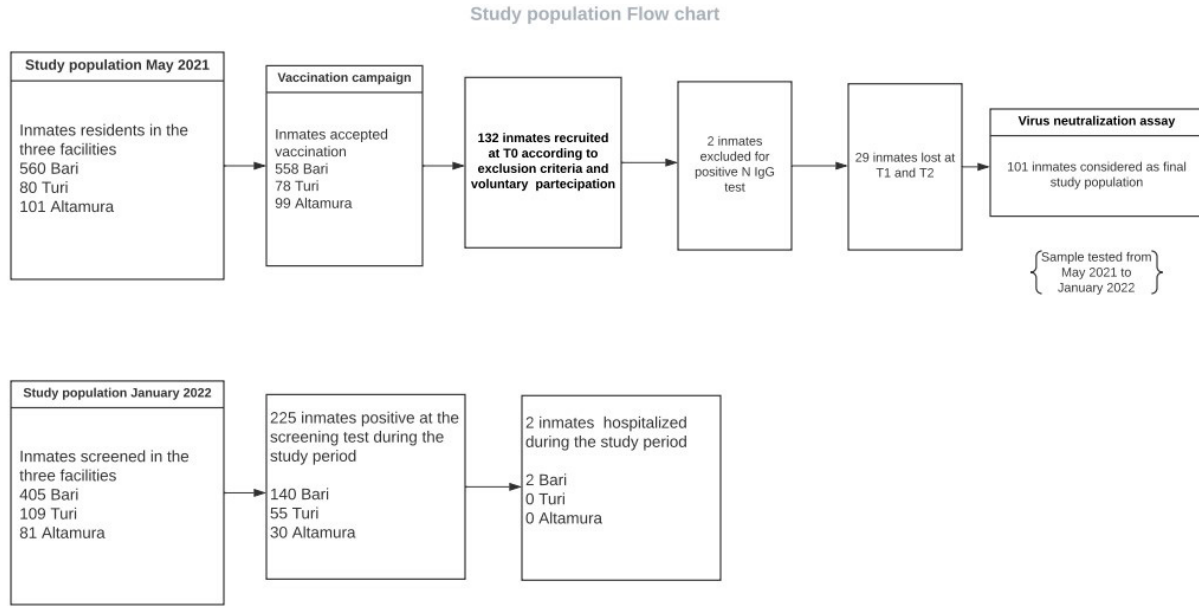
Figure 1. Study population flow chart.